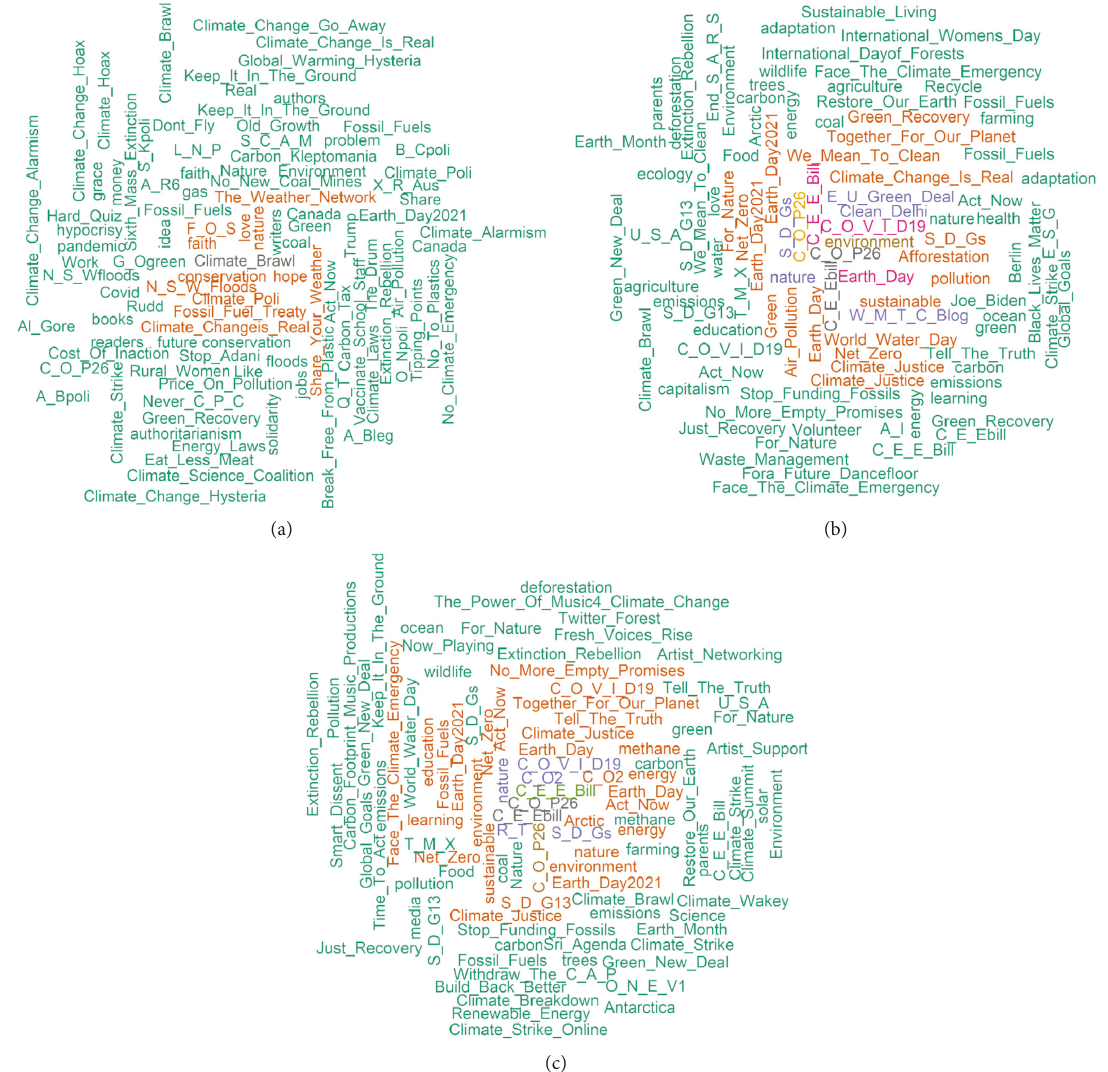
Figure 10: For replying (a), retweeting (b), and quoting (c) interactions, word cloud representation of